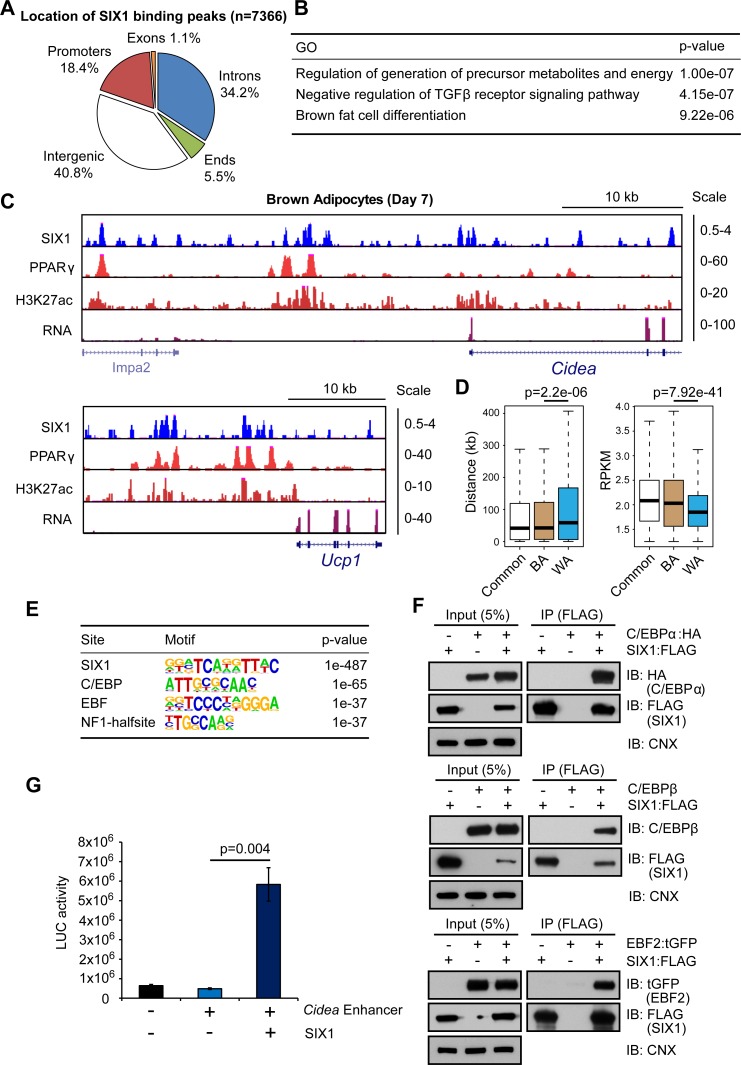
Genome-wide SIX1 binding analysis in mature BAs.(A) ChIP-seq analysis of SIX1 binding revealed that it binds preferentially to intergenic regions, promoters and introns. (B) Gene ontology analysis of genes associated with SIX1 binding peaks. (C) SIX1 binds to the cis-regulatory regions of the brown marker genes Cidea and Ucp1. PPARγbinding, H3K27ac and mRNA expression profiles are also shown at these loci. (D) Box plots comparing SIX1 binding signals (RPKM) at BA-specific, WA-specific and commonly expressed genes, and distances of the closest SIX1 binding site to the transcription start site of BA-specific, WA-specific and commonly expressed genes. (E) Motif analysis of SIX1 binding sites revealed enrichment of C/EBP, EBF and NF1 binding motifs. (F) Co-immunoprecipitation experiments confirmed physical interactions between SIX1 and C/EBPα, C/EBPβ, as well as EBF2 in HEK293 cells. (G) Luciferase assay in HEK293 cells transfected with a plasmid carrying the luciferase gene driven by a portion of the Cidea distal enhancer (see S12 Fig for details) with or without SIX1 over-expression. n = 3, Error bars represent standard deviation. p-values were calculated using the paired student’s t-test.